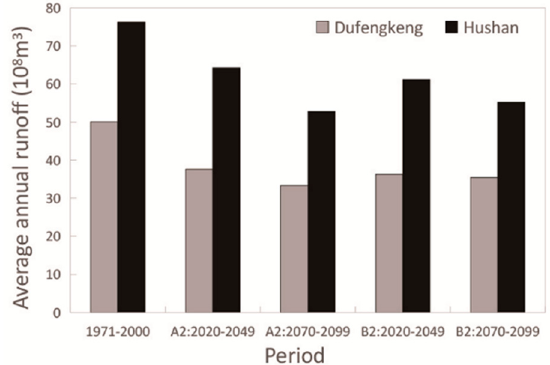
Figure 7. Average annual runoff for Dufengkeng Station and Hushan Station in the two future periods for the A2 and B2 scenarios.